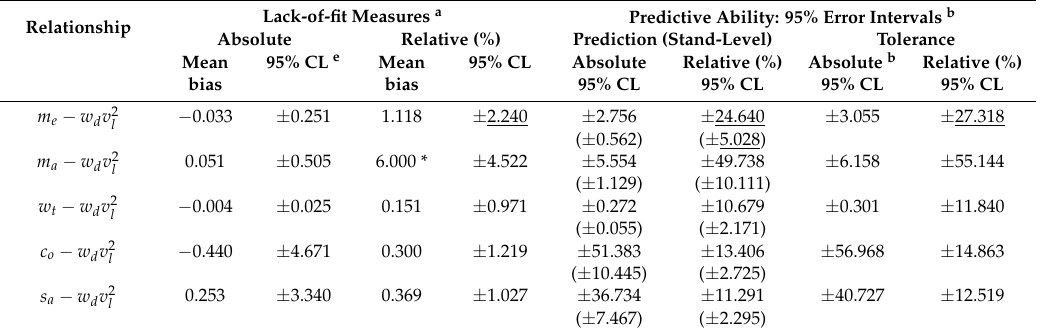
Table 9. Predictive performance of parameterized models when deploying acoustic-based wood density